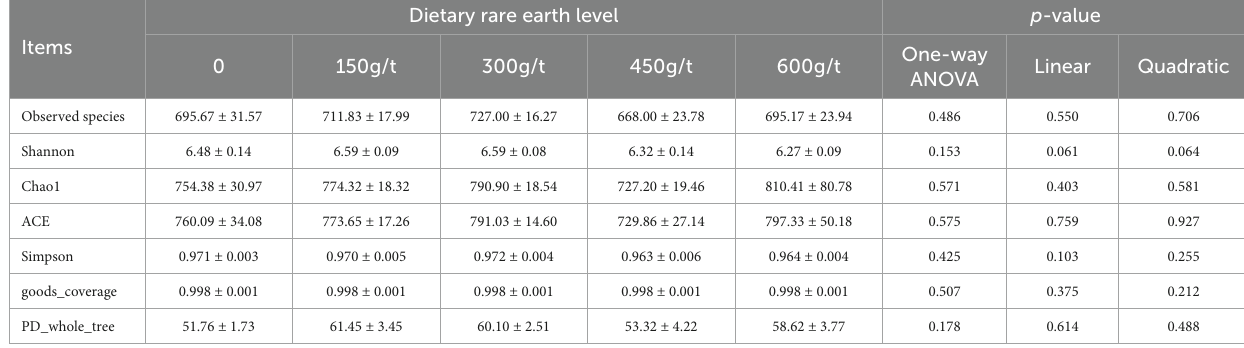
TABLE 7 Effects of dietary rare earth supplementation on alpha diversity indices of cecum microbiota in laying hens during the late laying stage ( n = 6).